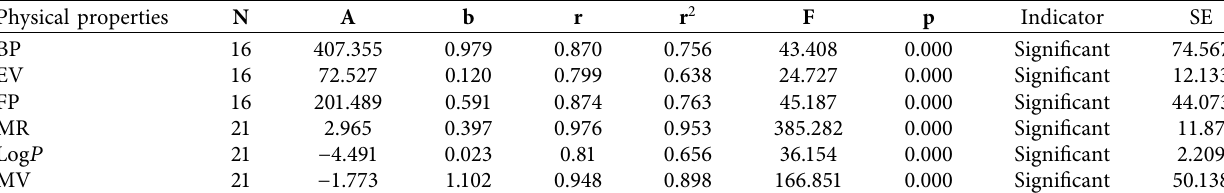
Table 9: Statistical specifications for the linear model of A ( G )